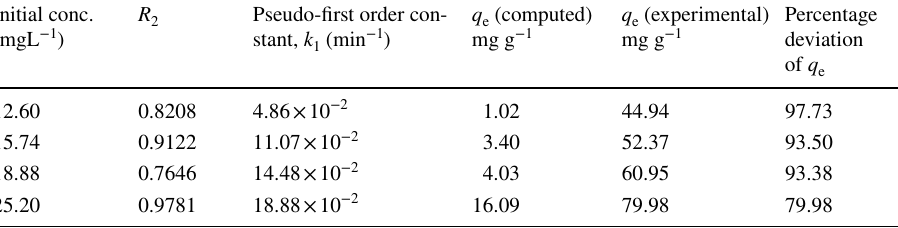
Initial conc. (mgL −1